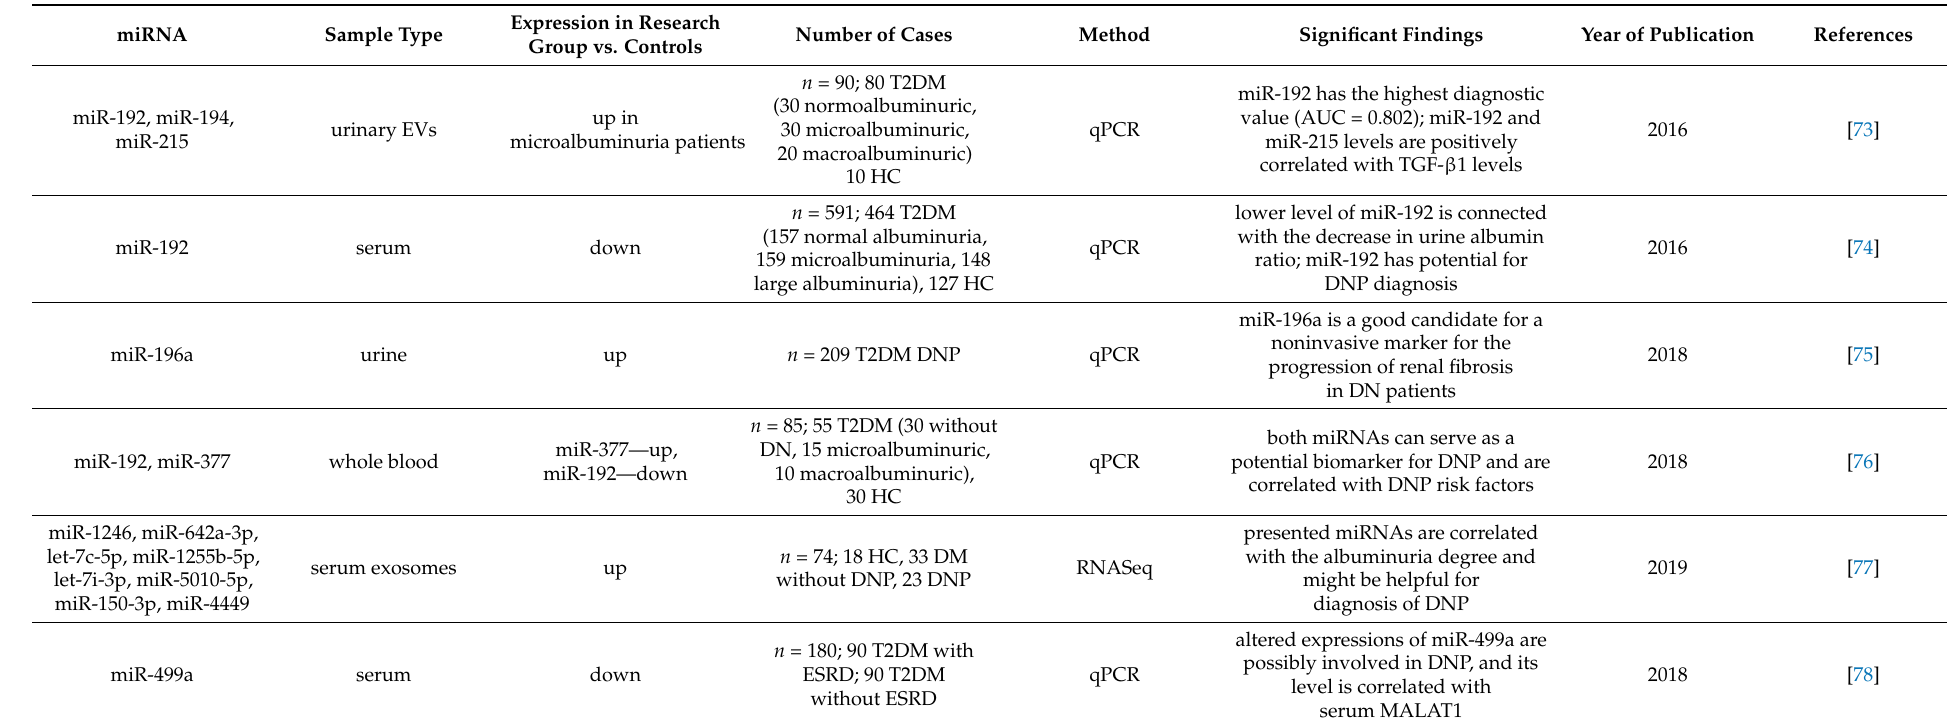
Table 3. Latest reports concerning miRNAs in biofluids of human patients with